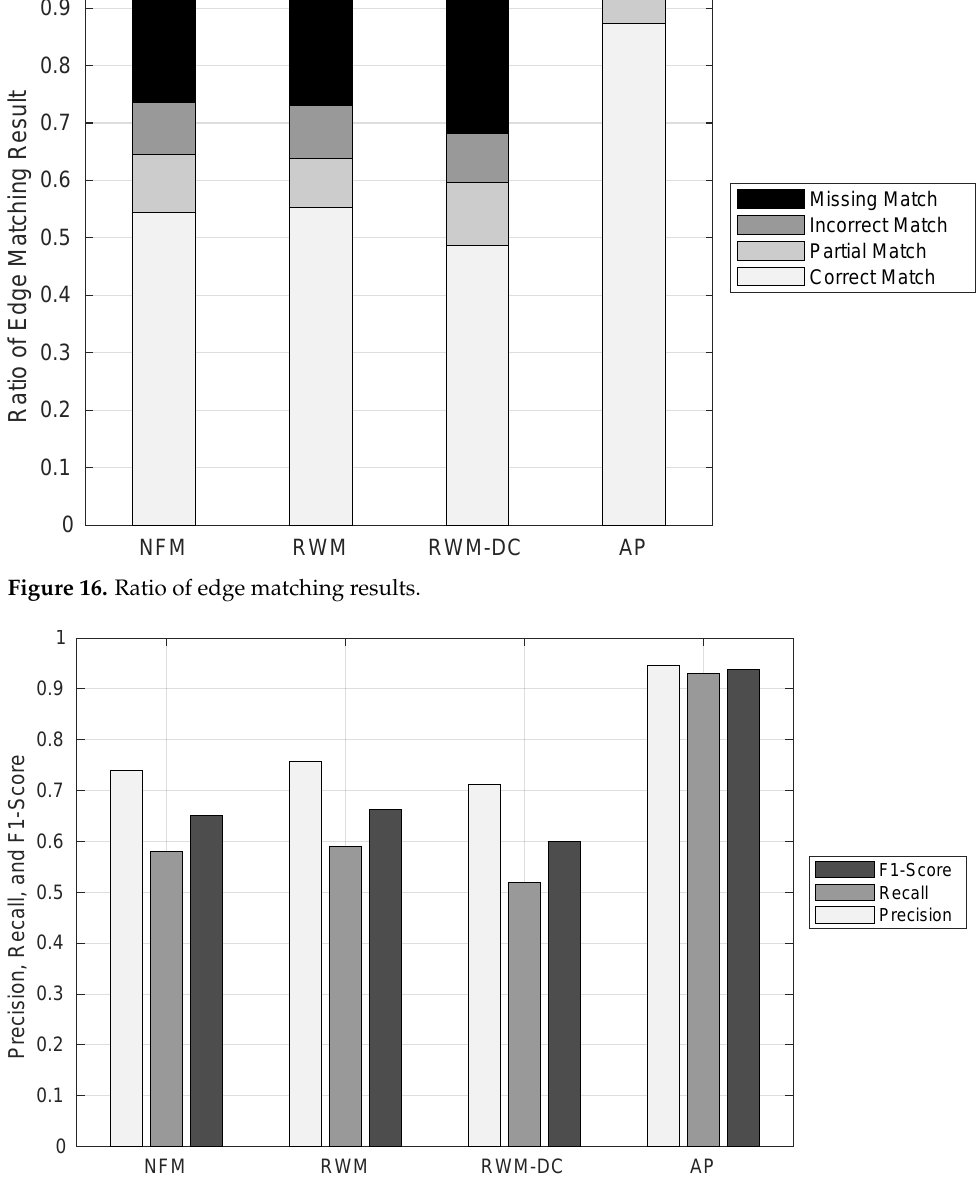
Figure 17. Precision, recall, and F1-score of edge